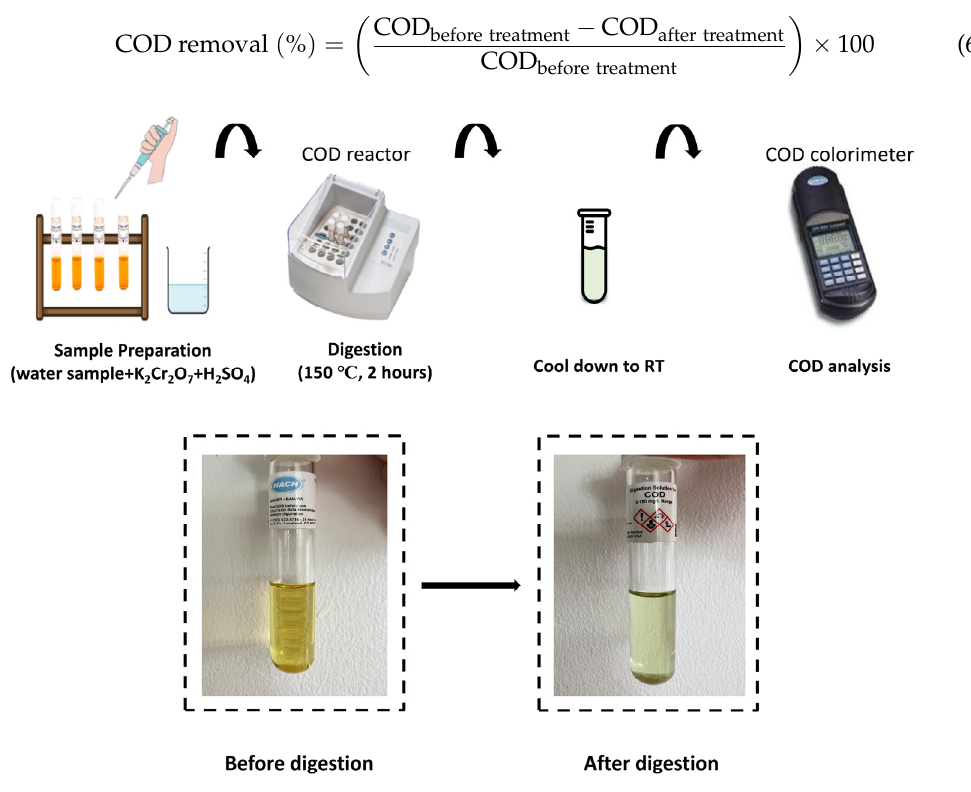
Figure 3. The flowchart of COD determination.